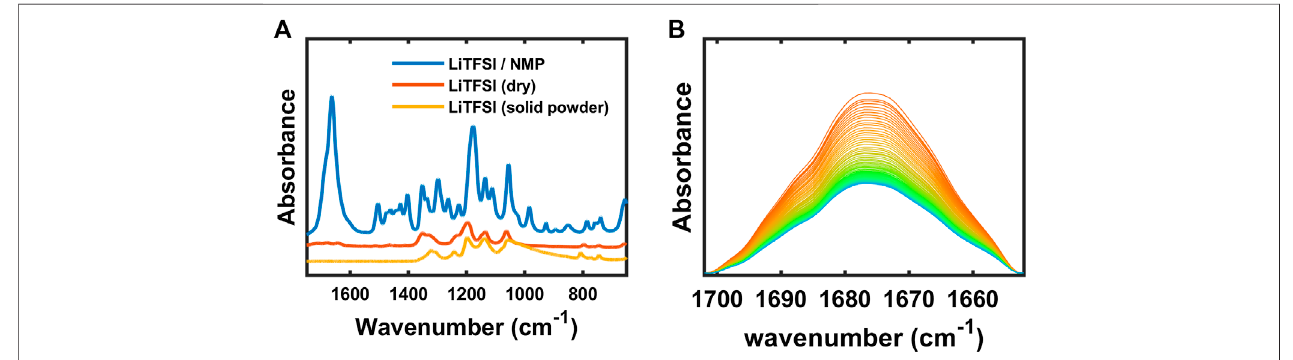
Frontiers in Energy Research |